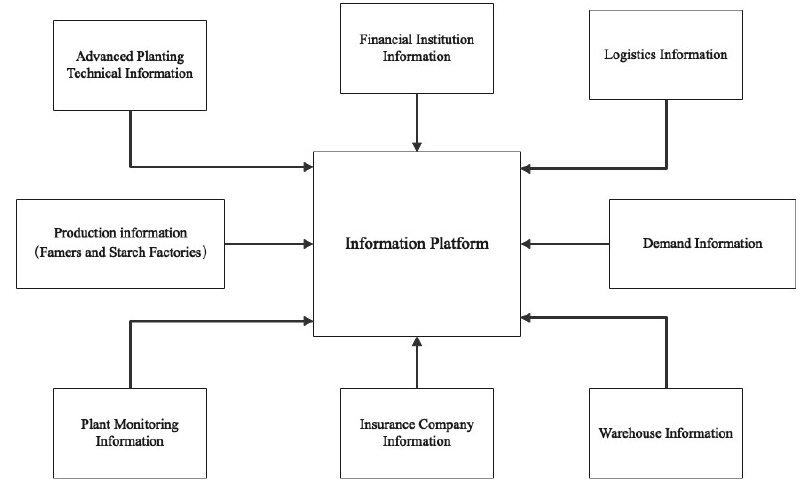
Figure 5. Information integration model of Tudouec.